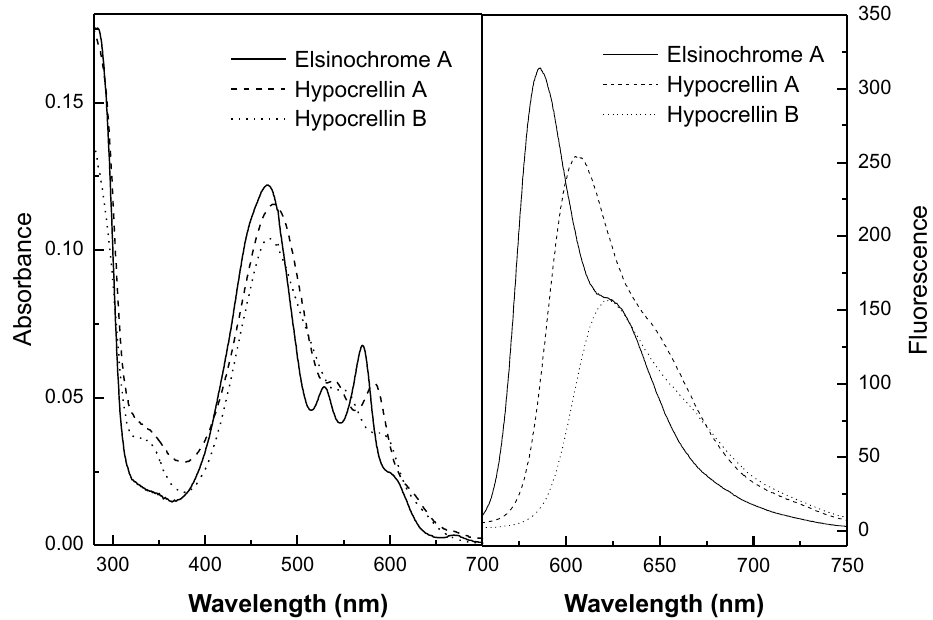
Fig. 2. Absorption spectra and °uorescence emission spectra of EA, HA and HB in DMSO solution.